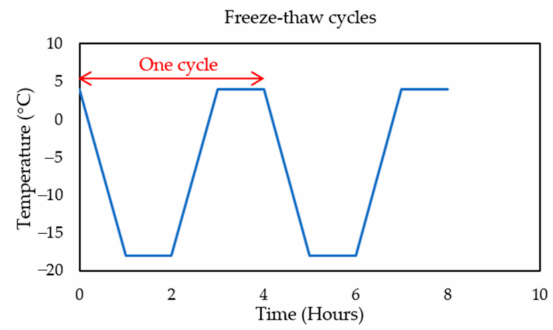
Figure 2. One freeze–thaw cycle.